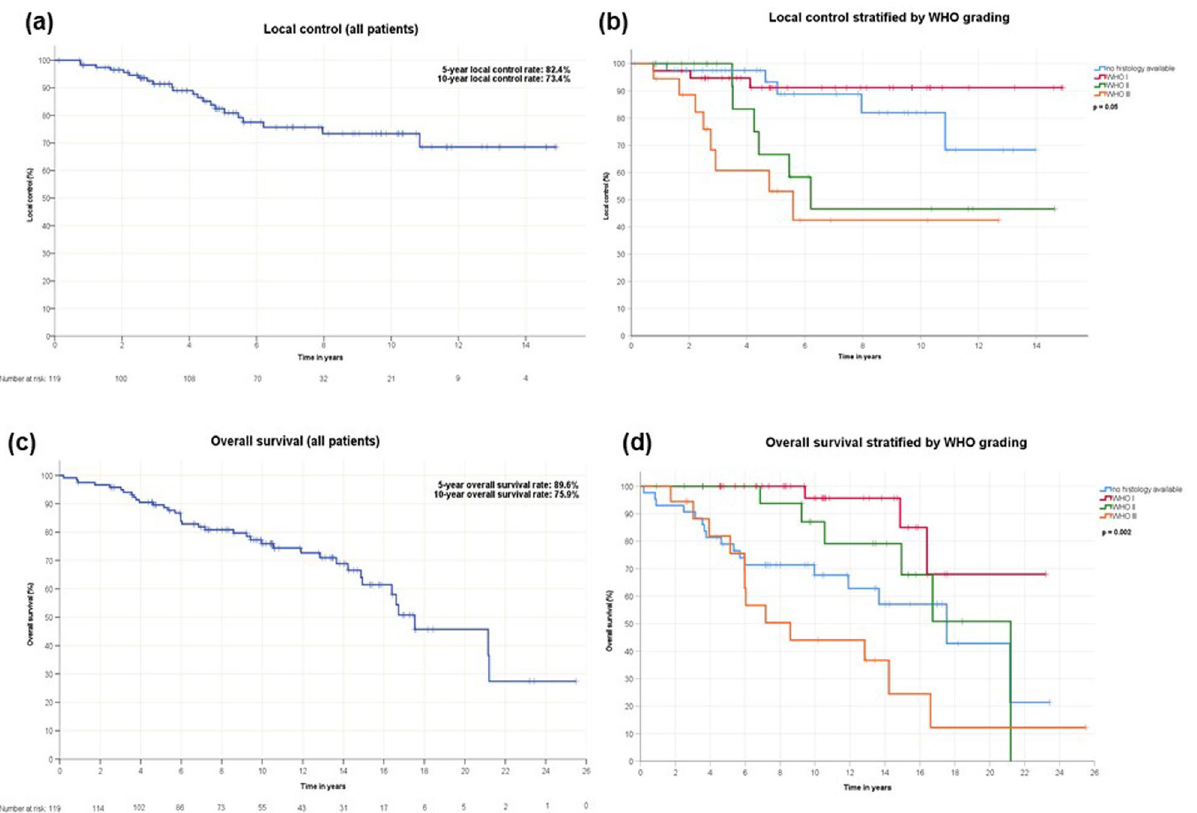
Figure 2. Local control shown by Kaplan–Meier analysis for all patients ( a ) and stratified by the WHO grading ( b ). WHO grading was suggestive for influencing local control ( p = 0.05). Overall survival shown by Kaplan– Meier analysis for all patients ( c ) and stratified by the WHO grading ( d ). WHO grading was highly significant for overall survival ( p =